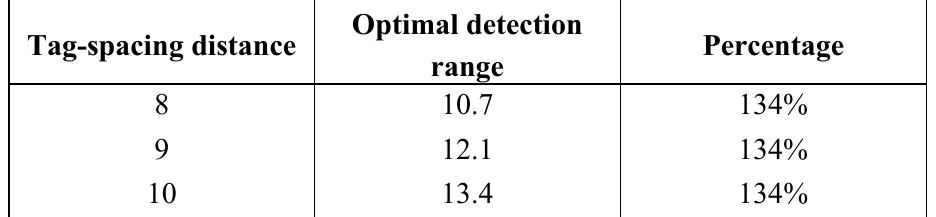
Table 3. Optimal detection range in 2-dimensional